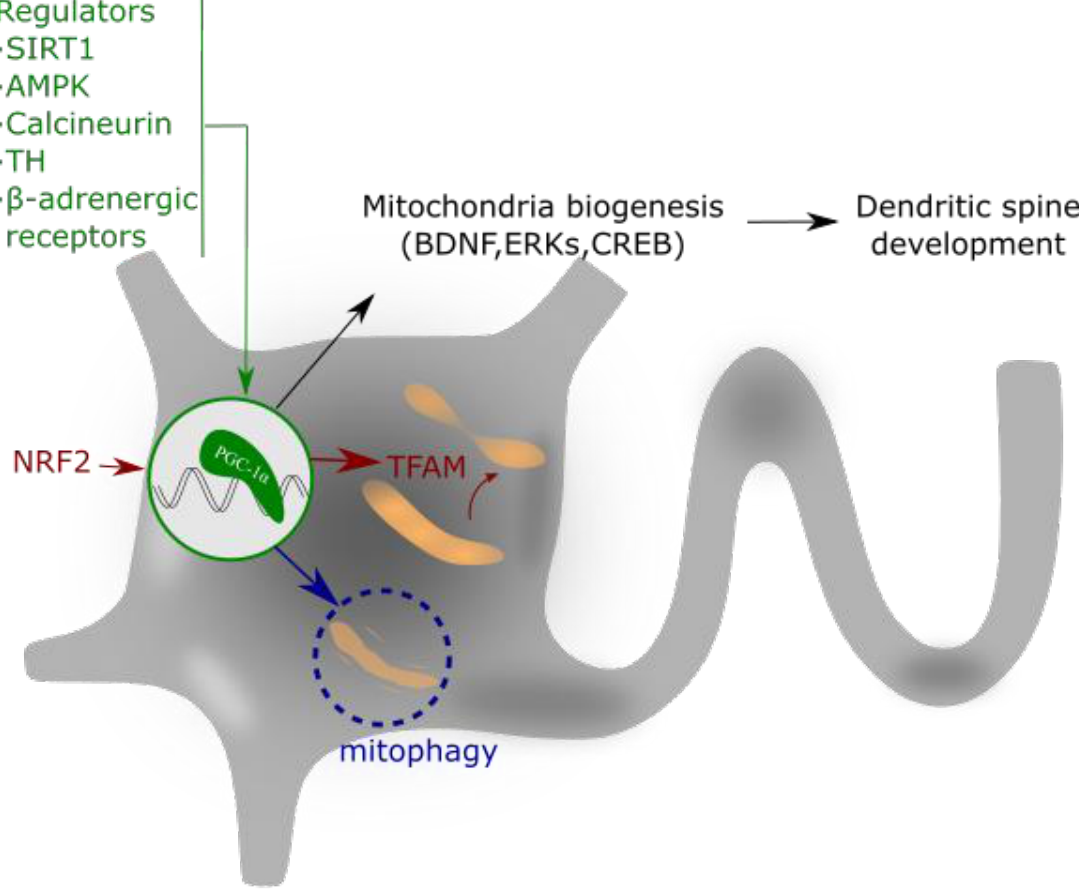
Figure 3. PGC-1α regulates mitochondrial biogenesis and spine growth. Its activity is based on the interaction with NRF that activates to TFAM. This complex regulates mitochondrial gene expression and addresses the requirements of neuronal energy when needed for dendrite activity or growth. PGC-1α expression is regulated by different intracellular signaling pathways, as explained in the text.